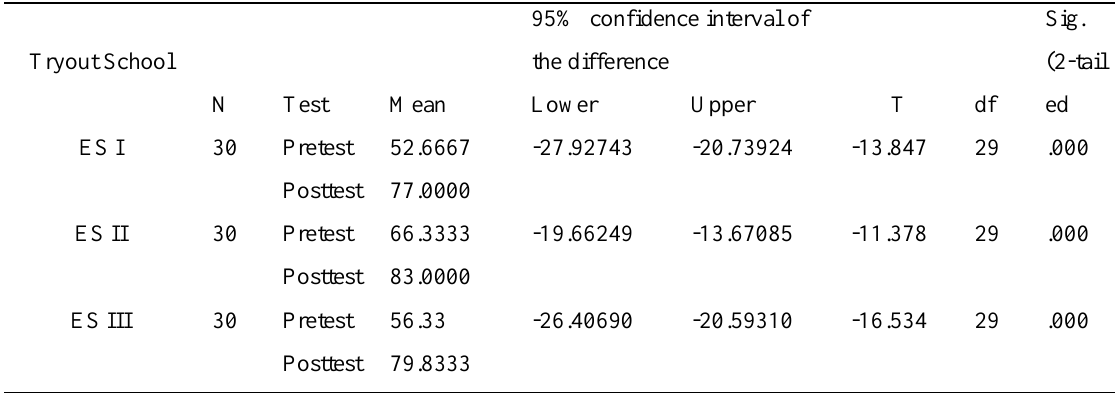
TABLE 5 | The Result of the pre-test and